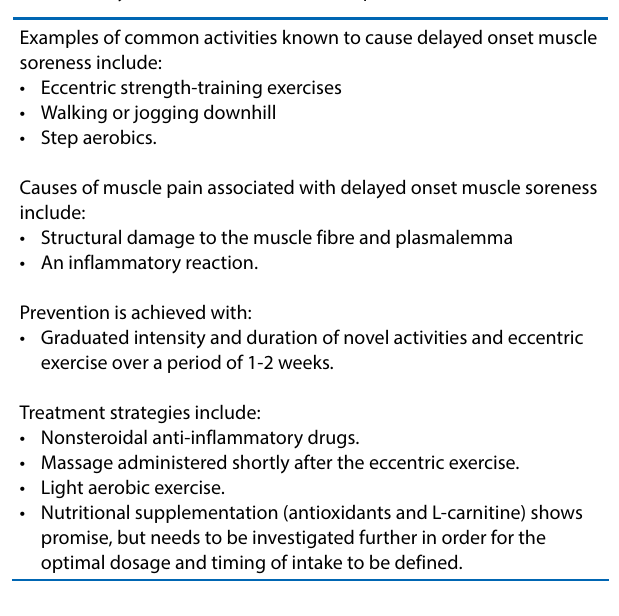
Table I: Delayed onset muscle soreness explained 1